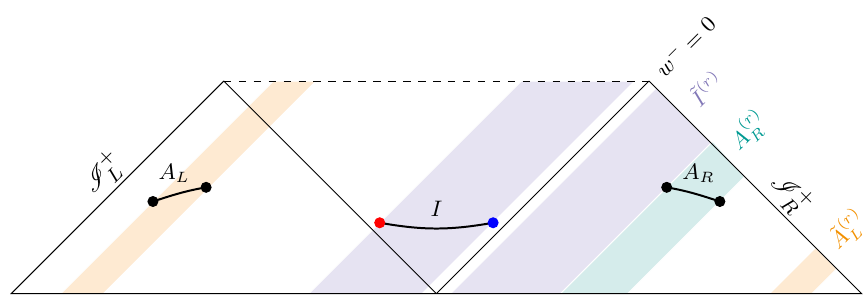
Figure 16 . The right-moved modes at I + that pass through A R and the purifiers from A L ∪ I R that are mapped onto I + via the involution about the horizon w − = 0 as R